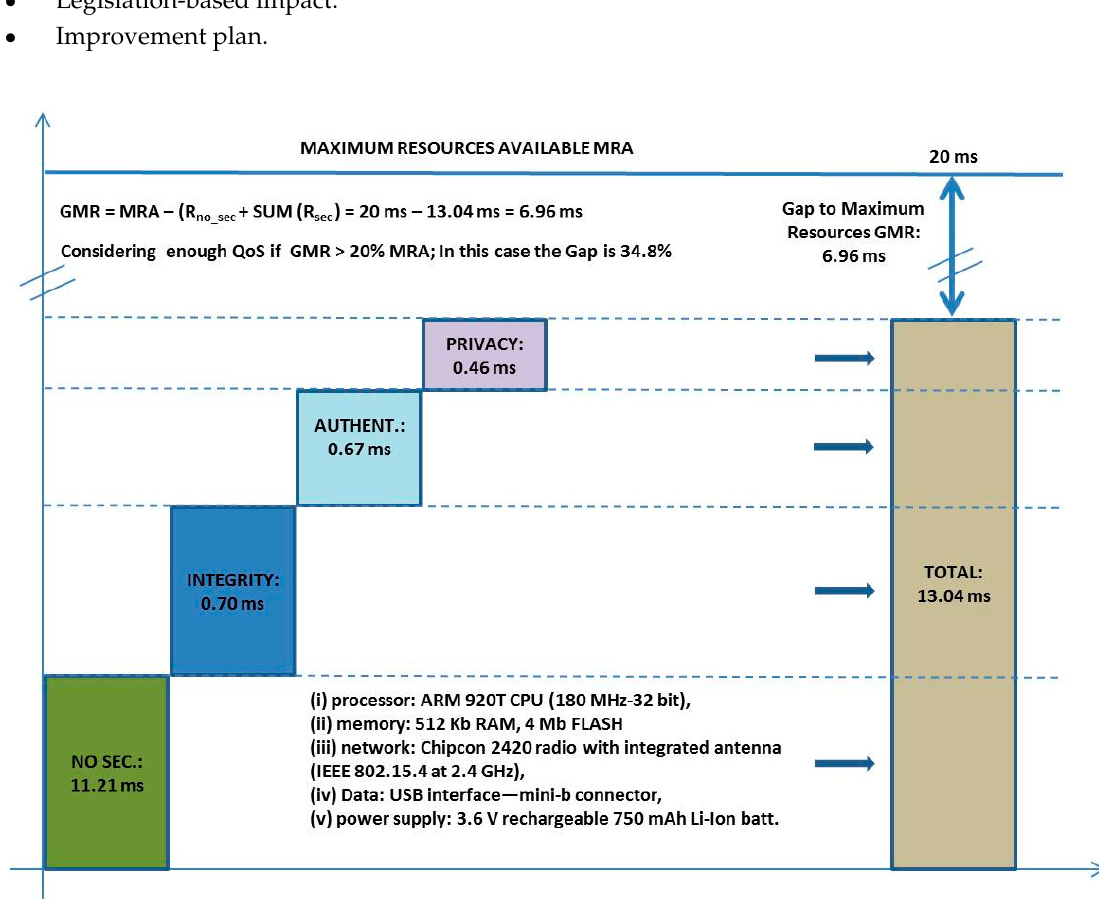
Table 11. Citizen protection impact and reaction.